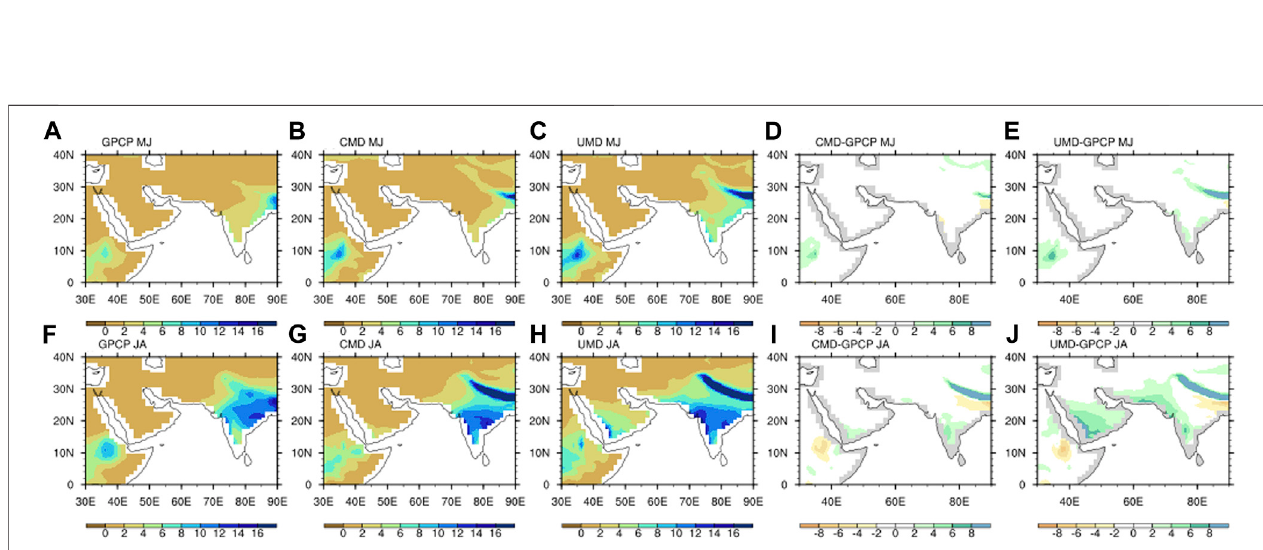
FIGURE 5 | The averaged precipitation (unit: mm/day) from GPCP, simulations and their differences in the early monsoon May – June; (A – E) and late monsoon July – August; (F – J) seasons in GPCP (A,D) , CMD simulations (D,E) , UMD simulations (C,F) , CMD − GPCP (D,I) and UMD − GPCP (F,J) .